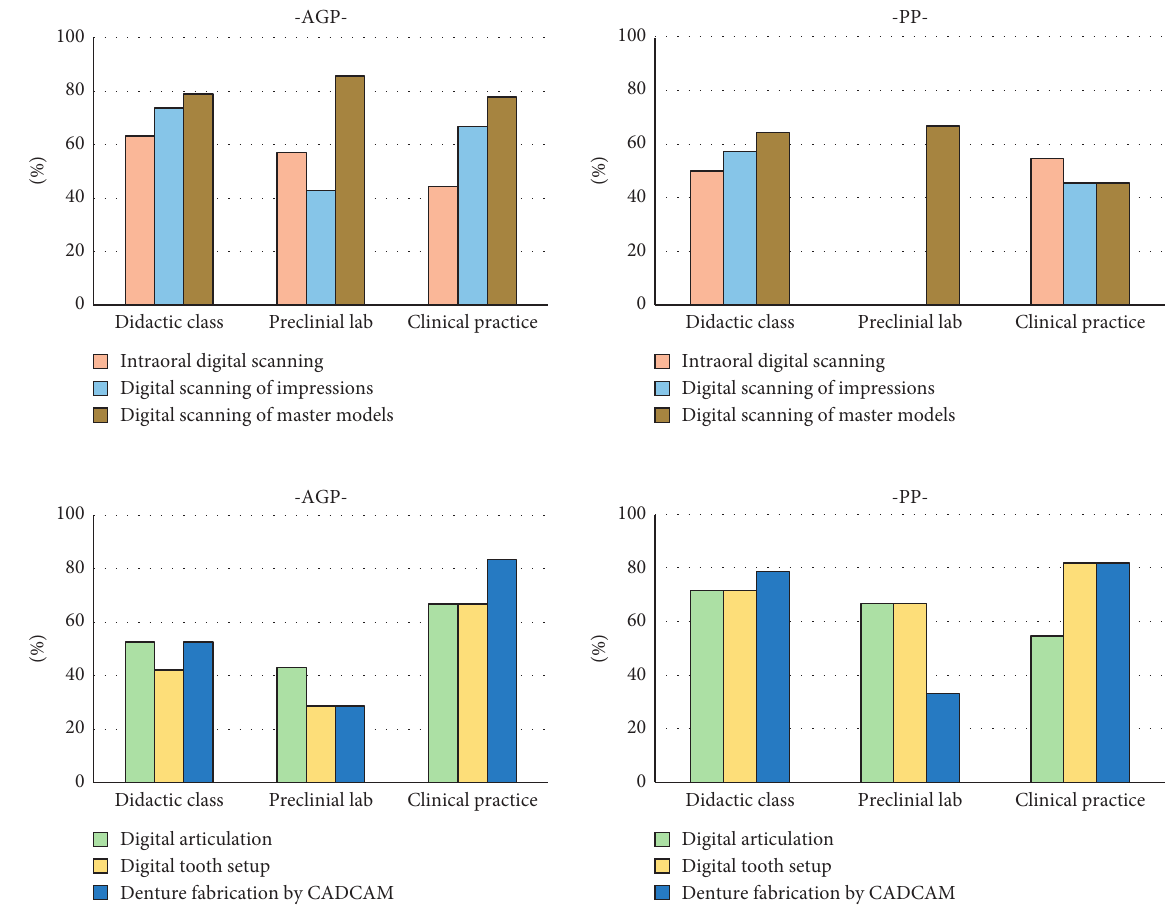
Figure 2: Contents of CAD-CAM complete denture teaching in didactic class, preclinical lab, and clinical practice. PP: predoctoral prosthodontics; AGP: advanced graduate Table 2: The characteristic of CAD-CAM CD system used, and the percentage of cases fabricated using CAD-CAM technology. CAD-CAM CD denture system used